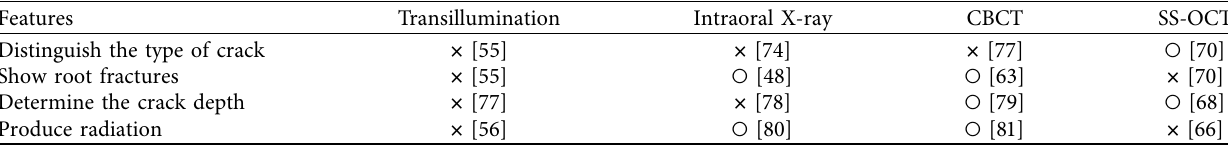
Table 2: of four common techniques in detecting cracked teeth.